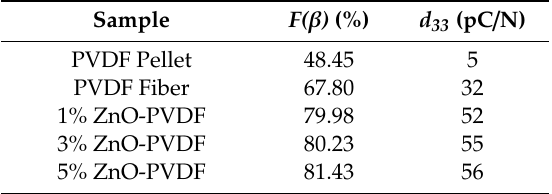
Table 2. Percentage of β phase and piezoelectric coe ffi cient ( d 33 ) in the fiber